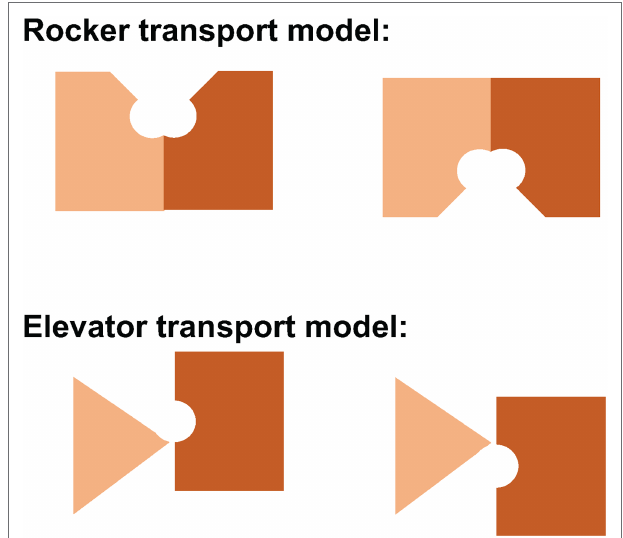
FIGURE 6 | Schematic representation of the rocker and elevator models of transport. In the rocker model ( above ), both domains undergo major conformational changes to allow alternating access of the central substrate binding site to one side of the membrane or the other. In the elevator model ( below ), the stationary domain (triangle) remains fixed in the plane of the membrane while the mobile domain (rectangle) moves up or down to allow alternating access to the central substrate binding site. In Band 3, the gate domain at the dimer interface is immobile while the core domain that contains the central substrate binding site moves relative to the plane of the